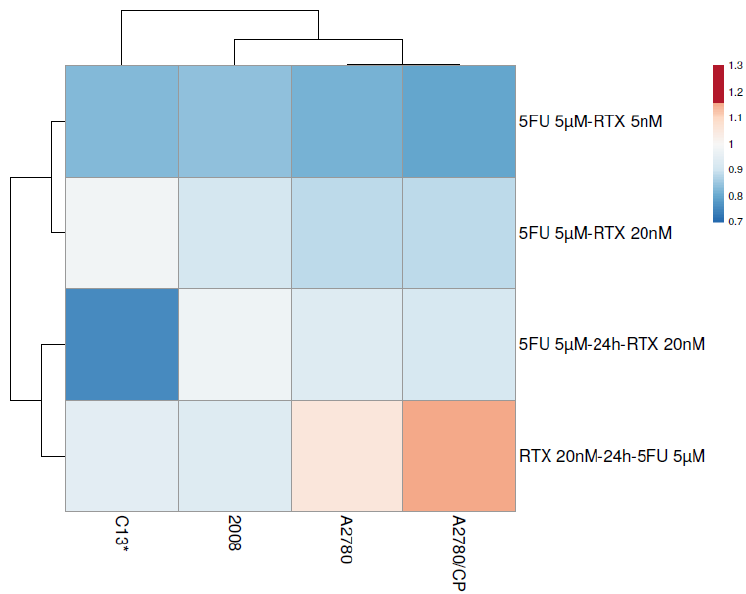
Figure 7. Heatmap representation of the synergism quotient values of the tested RTX-5FU combinations (rows) against the different cell lines (columns). Color code: red: sq > 1; blue: sq < 1. The data are reported in Table S4 of the Supplementary Information.